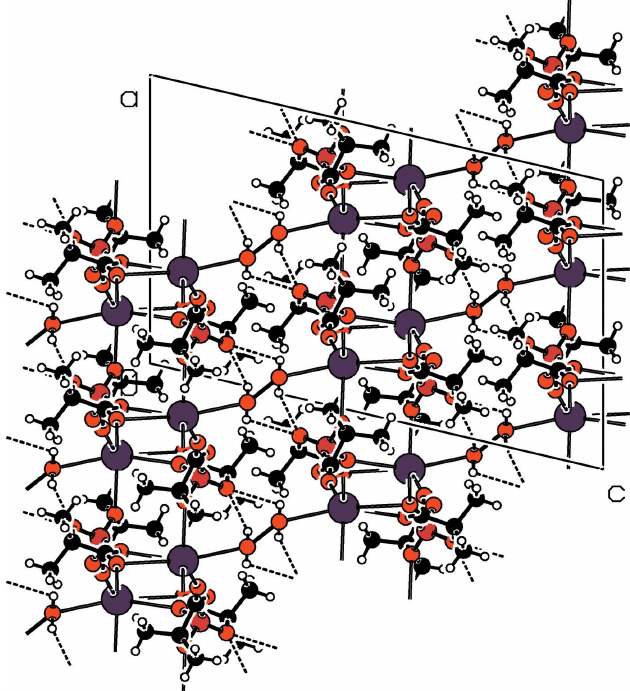
Figure 2 Packing diagram of the title compound viewed along the b axis. Dashed